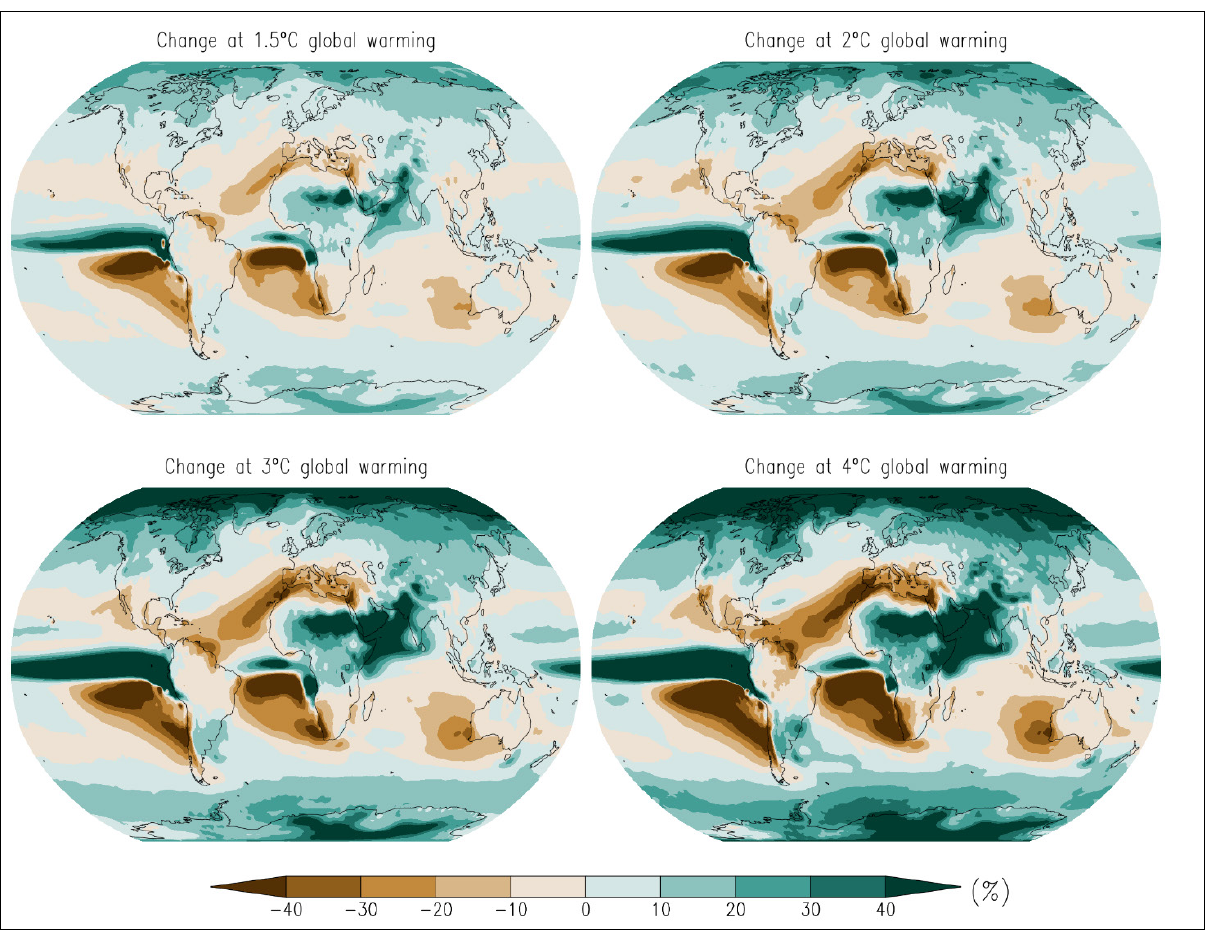
Figure 1: Projected spatial patterns of change in annual average precipitation (expressed as a percentage change) at different levels of global warming (1.5 °C, 2 °C, 3 °C, and 4 °C) relative to the period 1850–1900. Values were assessed from a 20-year period at a given warming level, based on model simulations under SSP5-8.5 by 30 global circulation models that contributed to the Coupled Model Intercomparison Project Phase Six